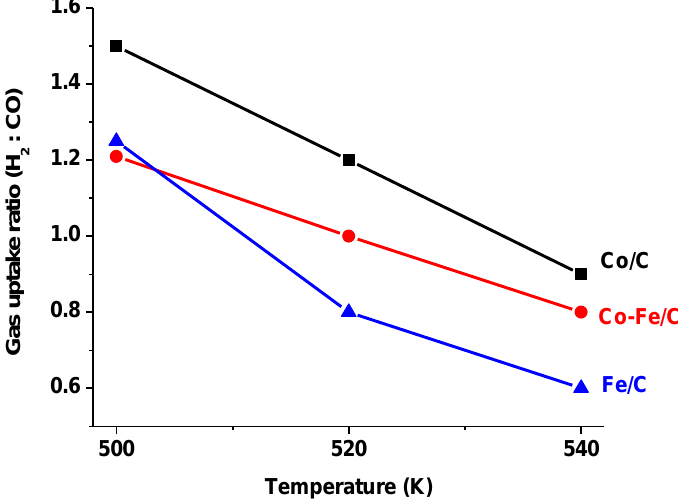
Figure 4. The H 2 :CO ratio, r, which indicates that all the catalysts, at higher temperatures, converted more CO to form CO 2 and probably with increased water-gas shift, FTS demanded less H 2 .